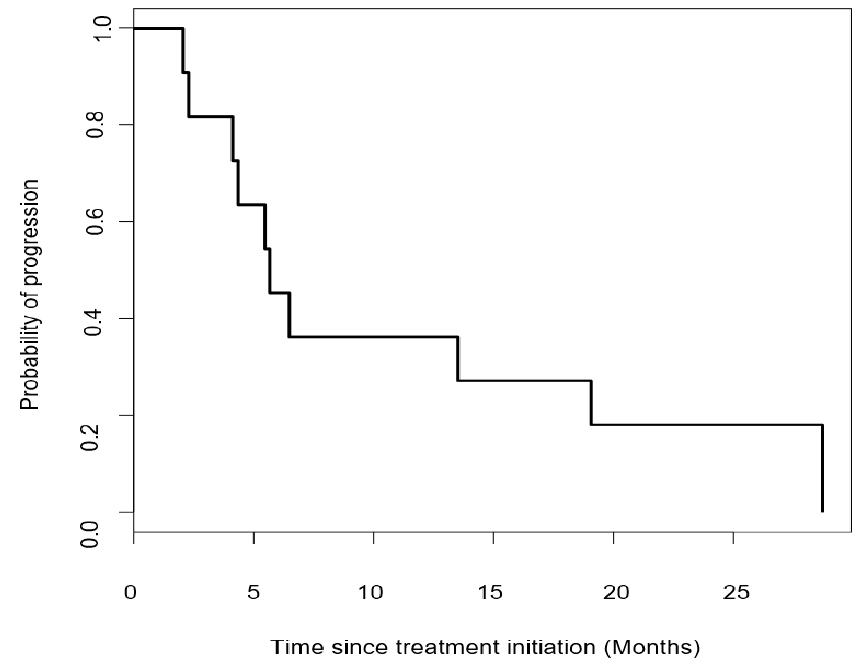
Figure 3. Kaplan-Meier curve of progression free survival in patients treated with pembrolizumab. The median progression free survival time was 5.7 months (95% CI: 4.37—not reached). The median survival duration was 19 months (95% CI = 9.9—not reached) (Figure 4).